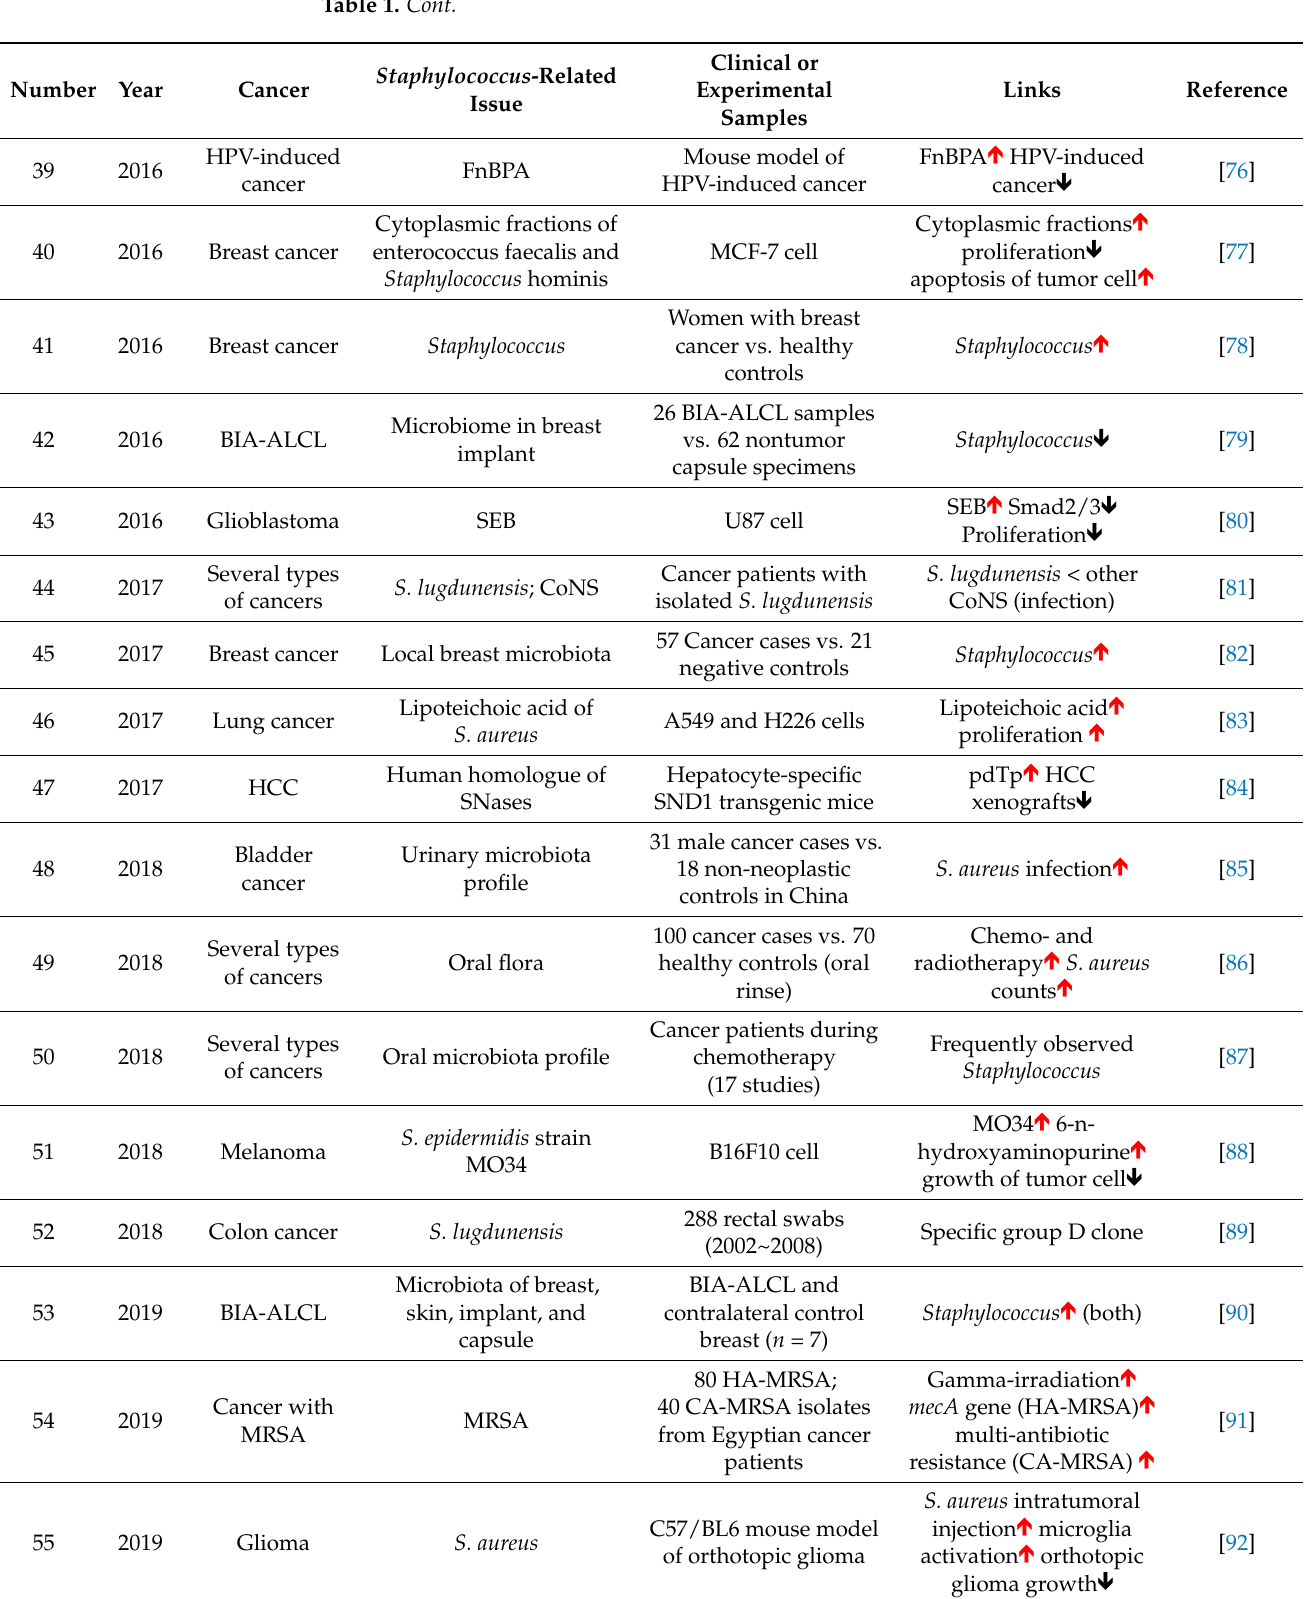
Table 1. Cont. Table 1. Summary of evidence on Staphylococcus and carcinogenesis. Table 1. Summary of evidence on Staphylococcus and carcinogenesis. Table 1. Summary of evidence on Staphylococcus and carcinogenesis. Table 1. Summary of evidence on Staphylococcus and carcinogenesis.